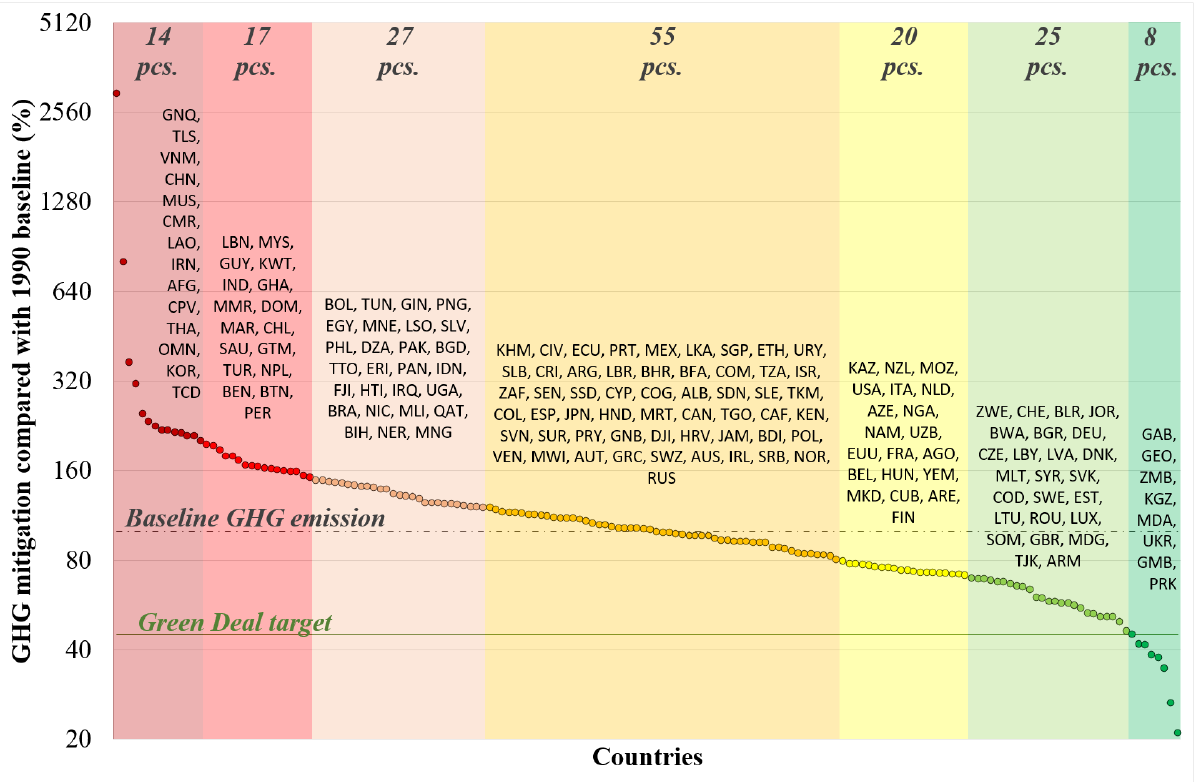
Figure 10. The actual GHG reduction percent in 2018 compared with 1990. The European Green Deal targets for 2030 to at least a 55% GHG reduction compared with 1990 levels. Country groups are color-coded based on their reduction percent. The ISO codes from right to left and top to bottom are in order with the countries’ location in each